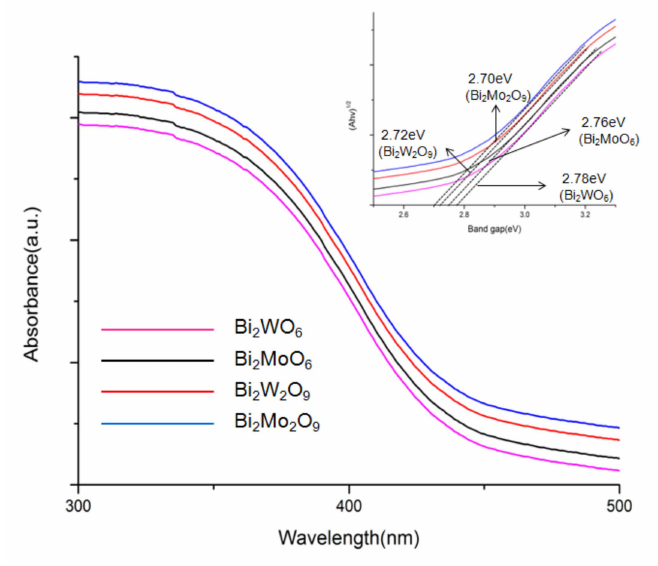
Figure 6. DRS spectra of Bi 2 WO 6, Bi 2 W 2 O 9 , Bi 2 MoO 6 and Bi 2 Mo 2 O 9 . The inset shows the band gap energies.